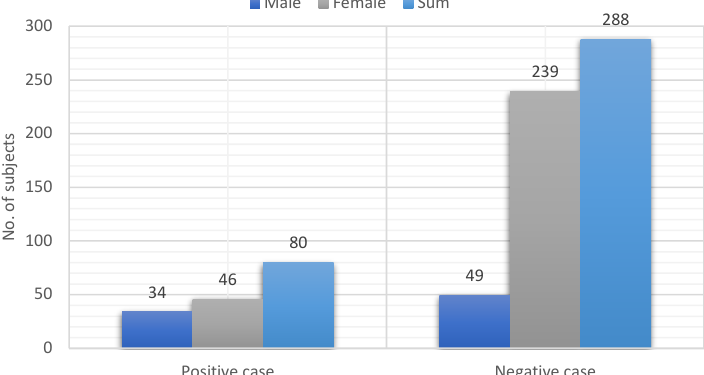
Figure 1. Distribution of samples in the